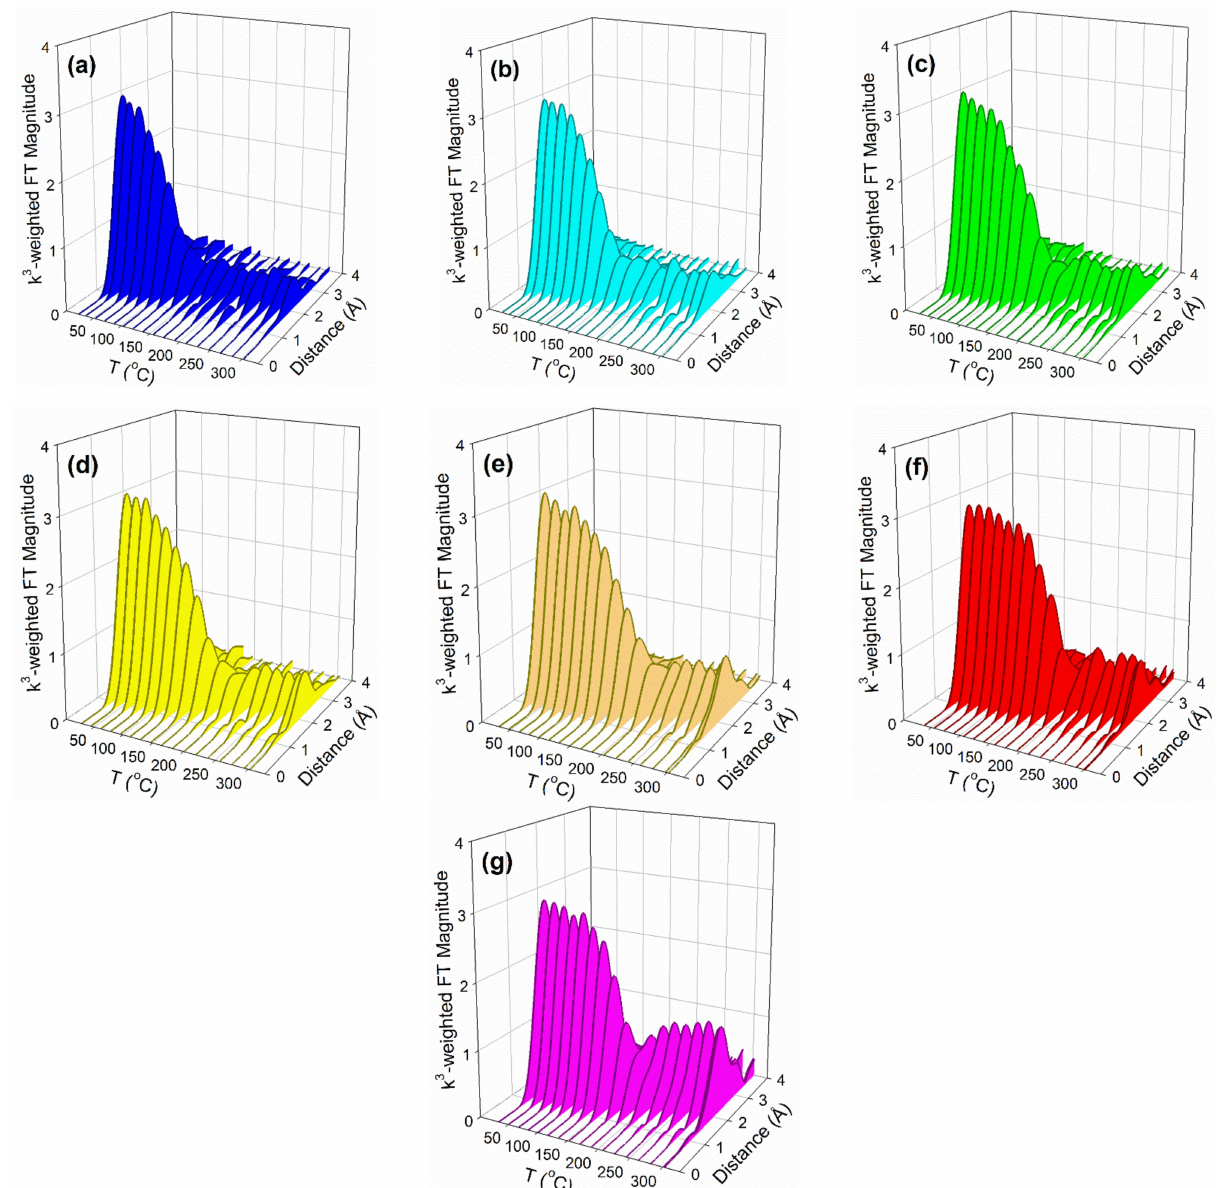
Figure 10. TPR-EXAFS spectra at the Pt L-3 edge of ( a ) 2%Pt/ZrO 2 , ( b ) 0.93%Rb-2%Pt/ZrO 2 , ( c ) 1.86%Rb-2%Pt/ZrO 2 , ( d ) 2.79%Rb-2%Pt/ZrO 2 , ( e ) 4.65%Rb-2%Pt/ZrO 2 , ( f ) 5.58%Rb-2%Pt/ZrO 2 , and ( g ) 9.29%Rb-2%Pt/ZrO 2